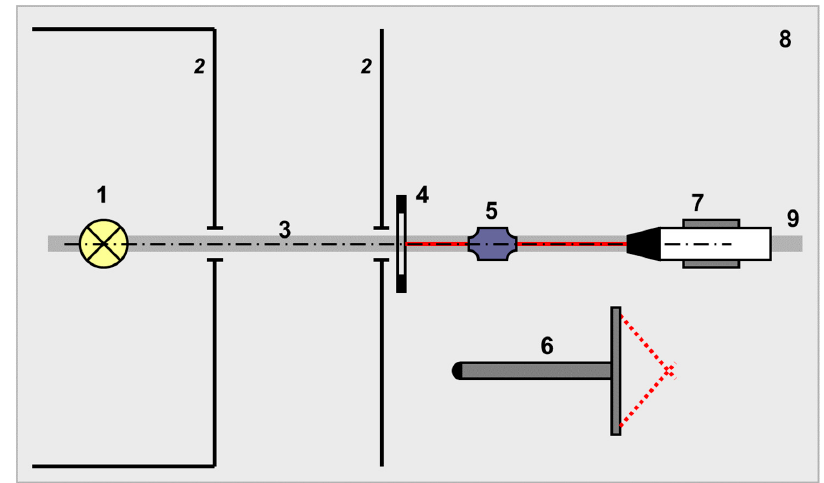
Figure3. Indoorirradiancecomparison. 1—FELlamp; 2—ba ffl es; 3—mainopticalaxis; Figure 3. Indoor irradiance comparison. 1—FEL lamp; 2—baffles; 3—main optical axis; 4—alignment jig; 5—alignment laser; 6—distance probe; 7—radiometer on the support; 8—optical table; 9—optical rail.